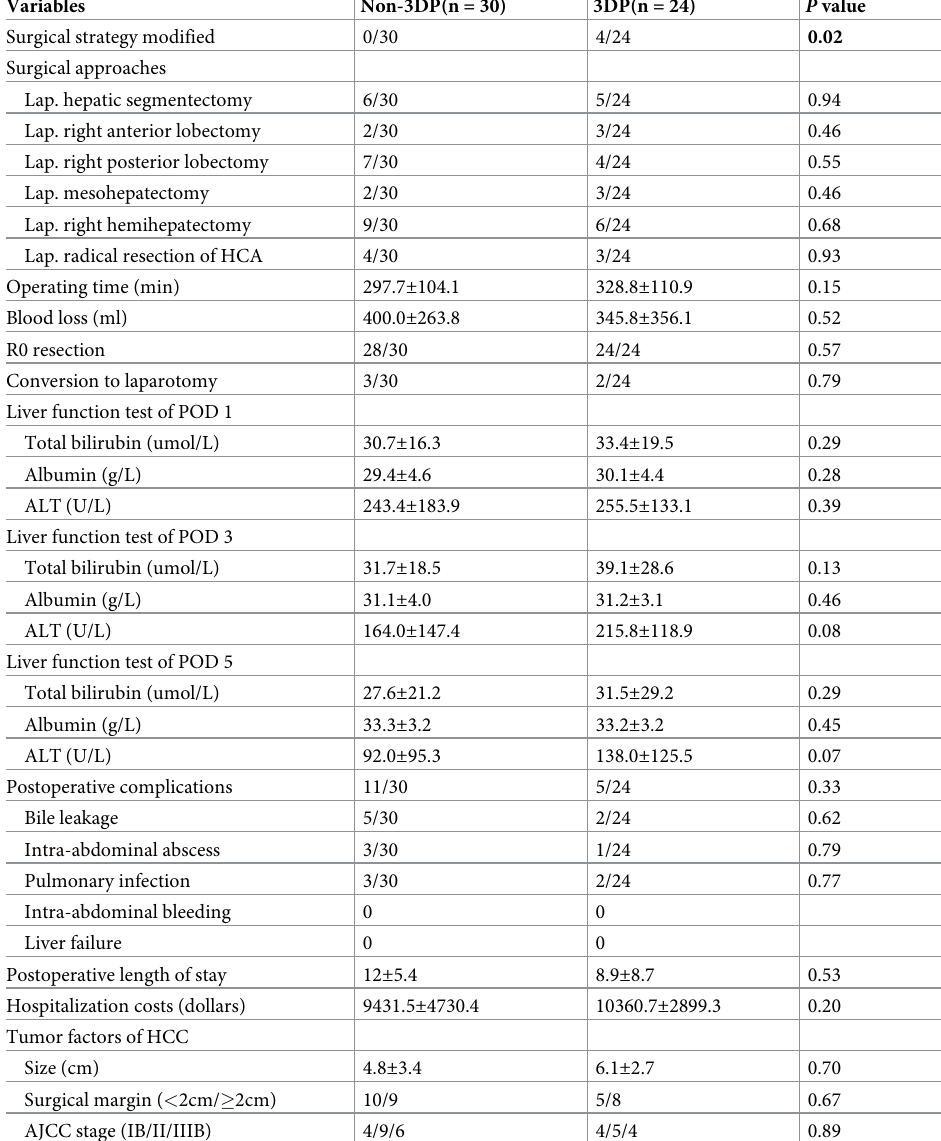
Table 2. Intraoperative and postoperative characteristics of the non-3DP and 3DP groups.